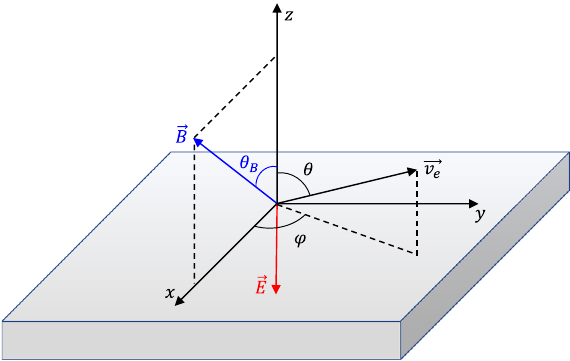
Figure 1. Schematic representation of magnetic field B , electric field E and secondary electron velocity v e